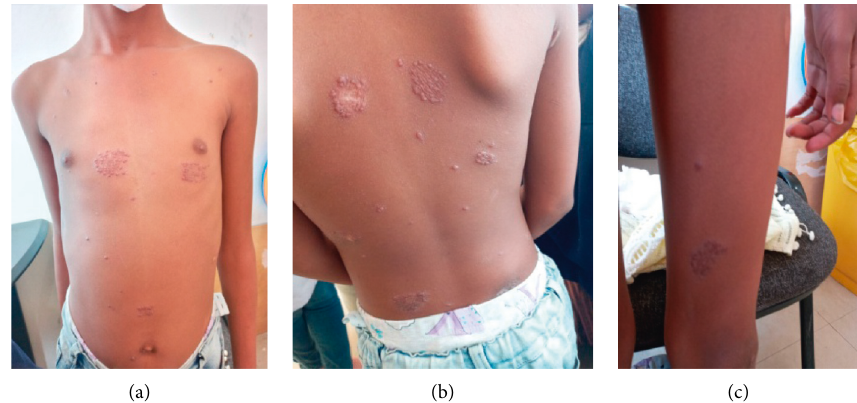
Figure 3: a,b, and c monomorphic grouped skin-colored papules and sparse discrete skin-colored papules on the chest, back, and left thigh